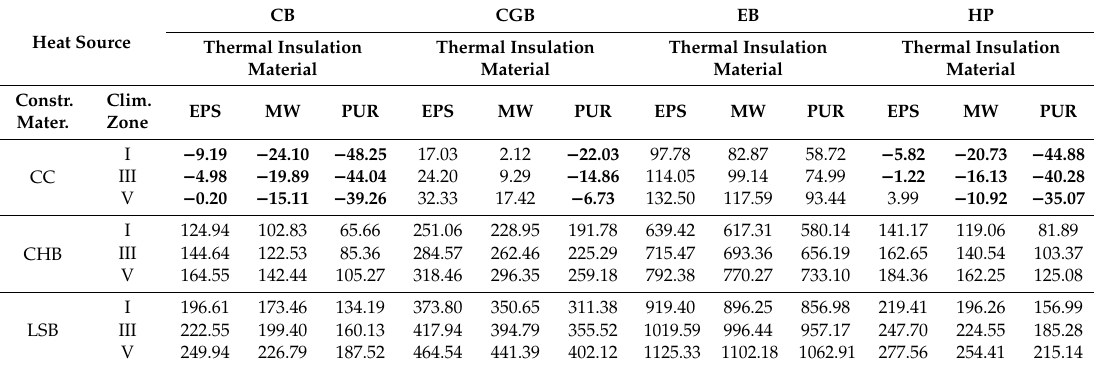
Table 10. NPV values [PLN / m 2 ] for U = U n .